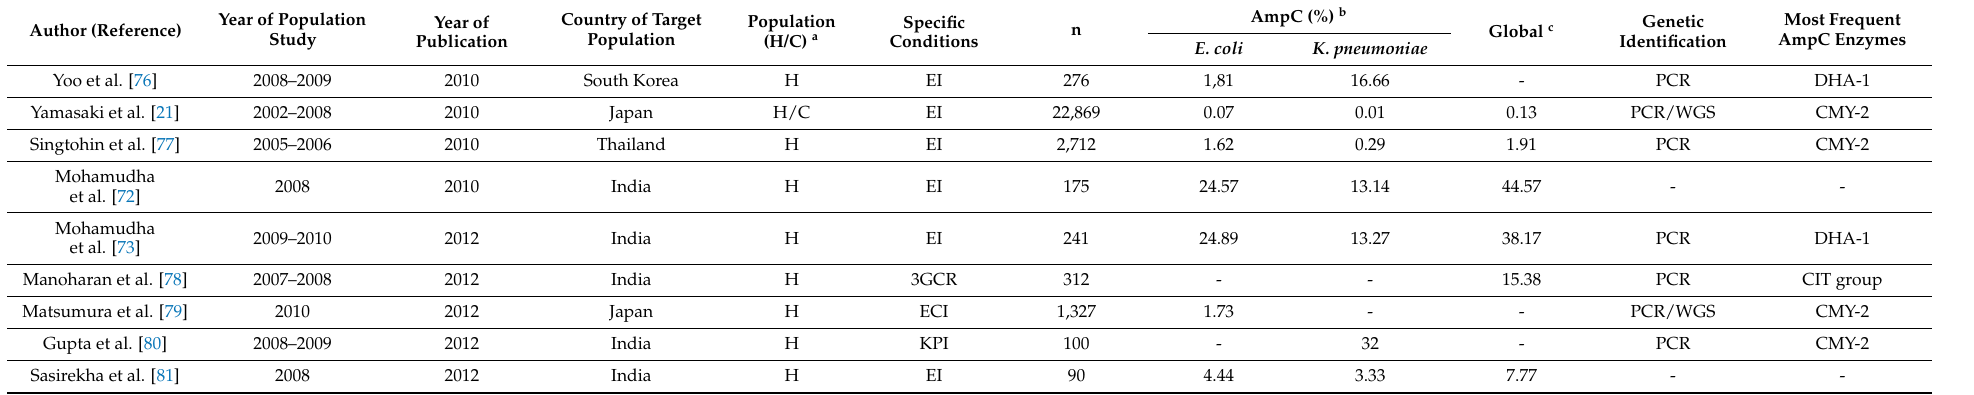
Table 5. Epidemiology of pAmpC-BLs in Asia, Oceania, and the Middle East